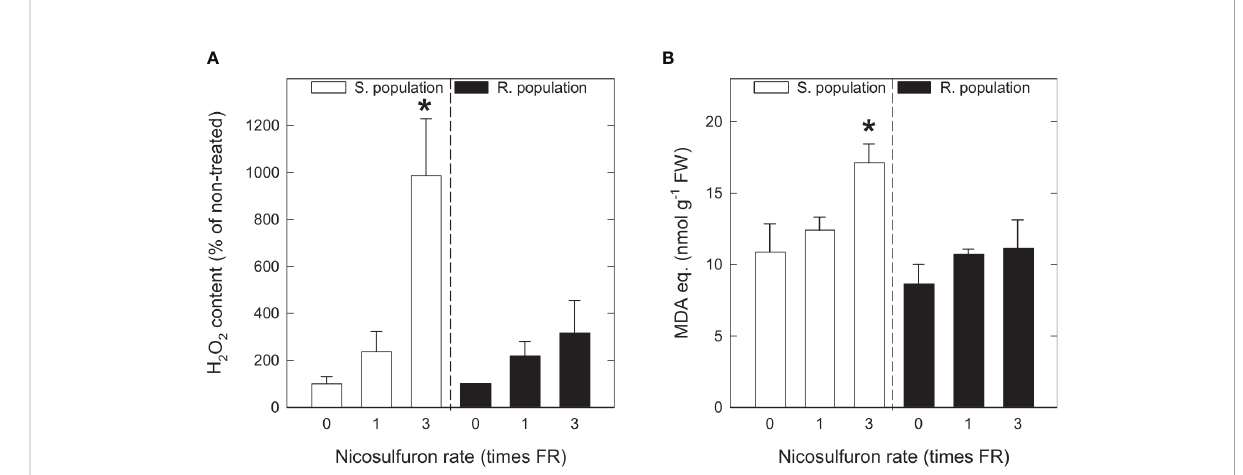
FIGURE 1 H 2 O 2 content (A) and malondialdehyde (MDA) equivalents (B) in Amaranthus palmeri sensitive (S, white) and resistant (R, black) populations treated with different nicosulfuron rates (X axis, times recommended fi eld rate or FR, FR = 0.06 kg ha -1 ). Mean ± SE (n = 4). For each population, signi fi cant differences between treatments and their respective untreated are highlighted with asterisks (Student ’ s t-test, p value ≤